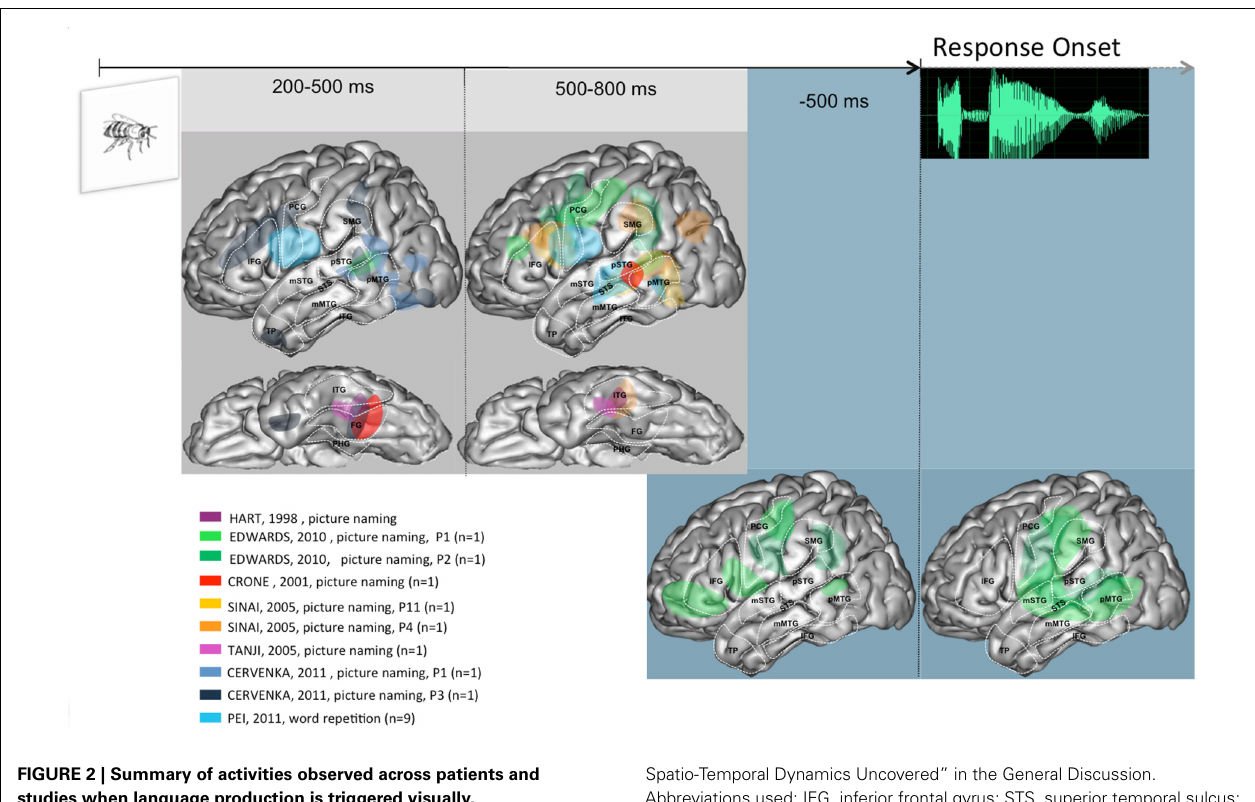
FIGURE 2 | Summary of activities observed across patients and studies when language production is triggered visually, projected on a standardized left hemisphere. The two figures on the gray background represent activities time-locked to stimulus presentation, at the indicated timings; lateral and basal views shown.The two figures on the blue background represent activities time-locked to response onset. Further details are provided in the Section “Overview of the